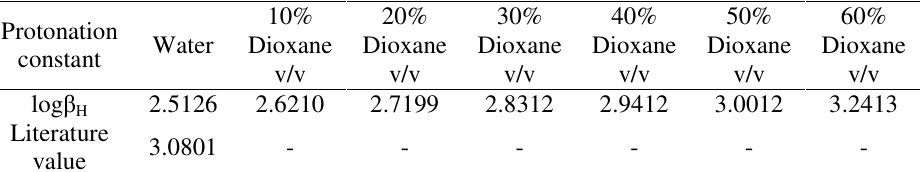
Table 2. Protonation constant of 2-oxo-1-pyrrolidine acetamide in different solvent media at